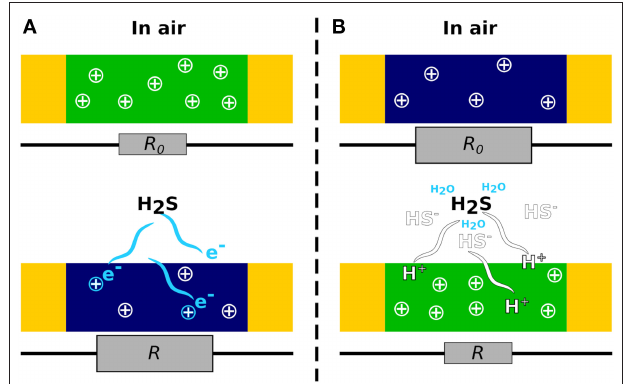
FIGURE 1 | Mechanisms of H 2 S detection by CPs. (A) The reducing gas H 2 S induces a reduction of the major charge carrier (holes, + ) resulting in an increase in CP resistance ( R 0 < R ). (B) In the presence of water, H 2 S releases protons, which increase the charge carrier in the polymer and thus decrease the resistivity ( R 0 > R